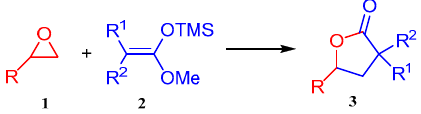
Figure 2. The best choice approach for the preparation of γ -lactones.